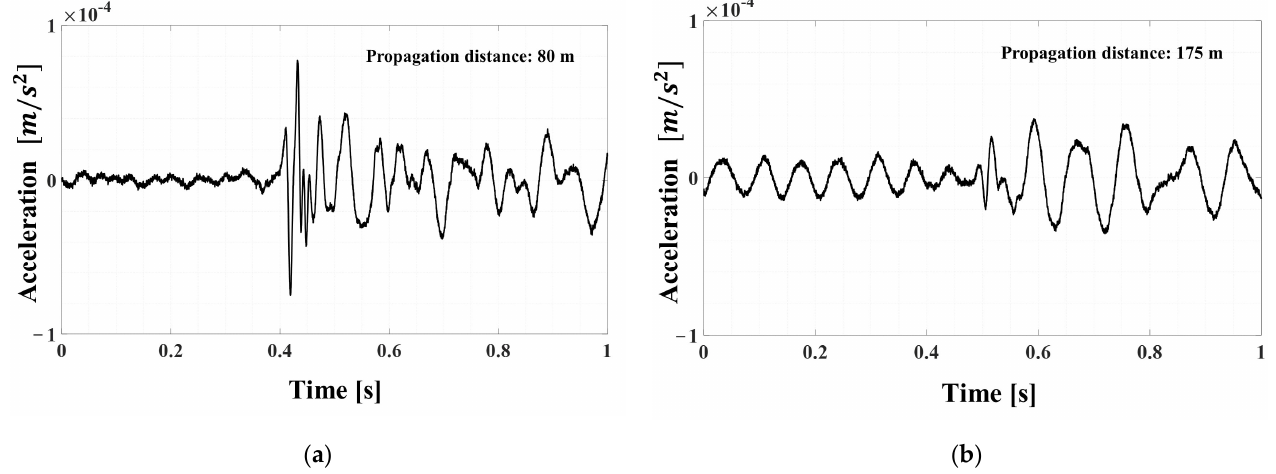
Figure 14. Time-domain signals obtained from each sensor: ( a ) sensor 1 and ( b ) sensor 2.